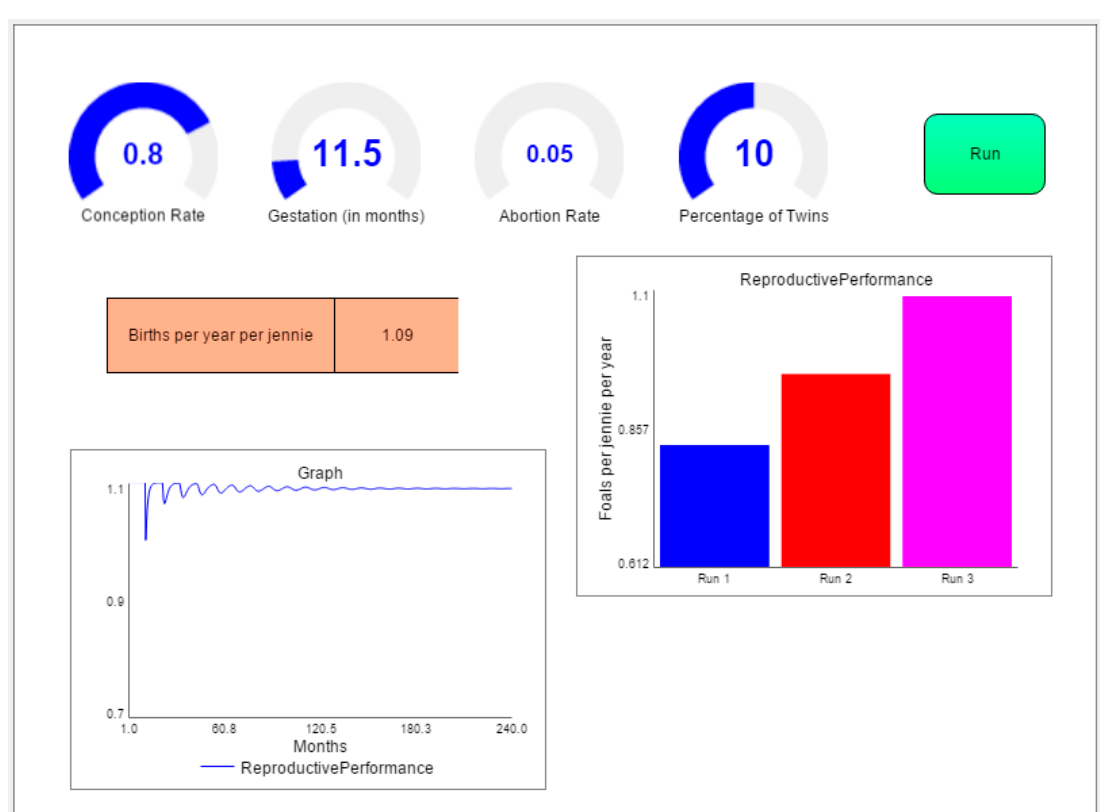
Figure B1. Reproduction model interface. Figure A1. Reproduction model